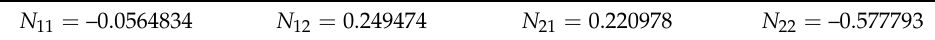
Table 8. Two-group bare reactor fluxes coefficients.